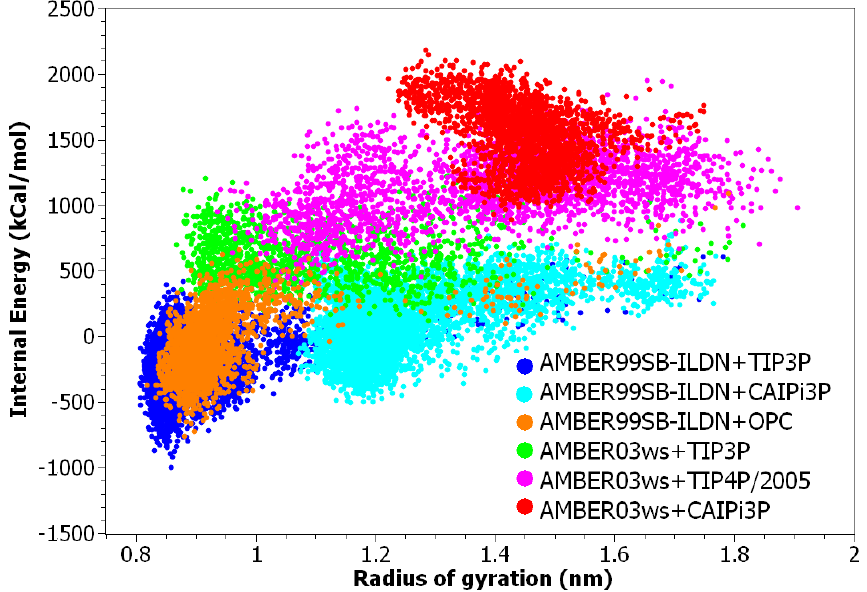
Figure 3. Histatin 5’s structural energy in the function of its radius of gyration. An increase in the